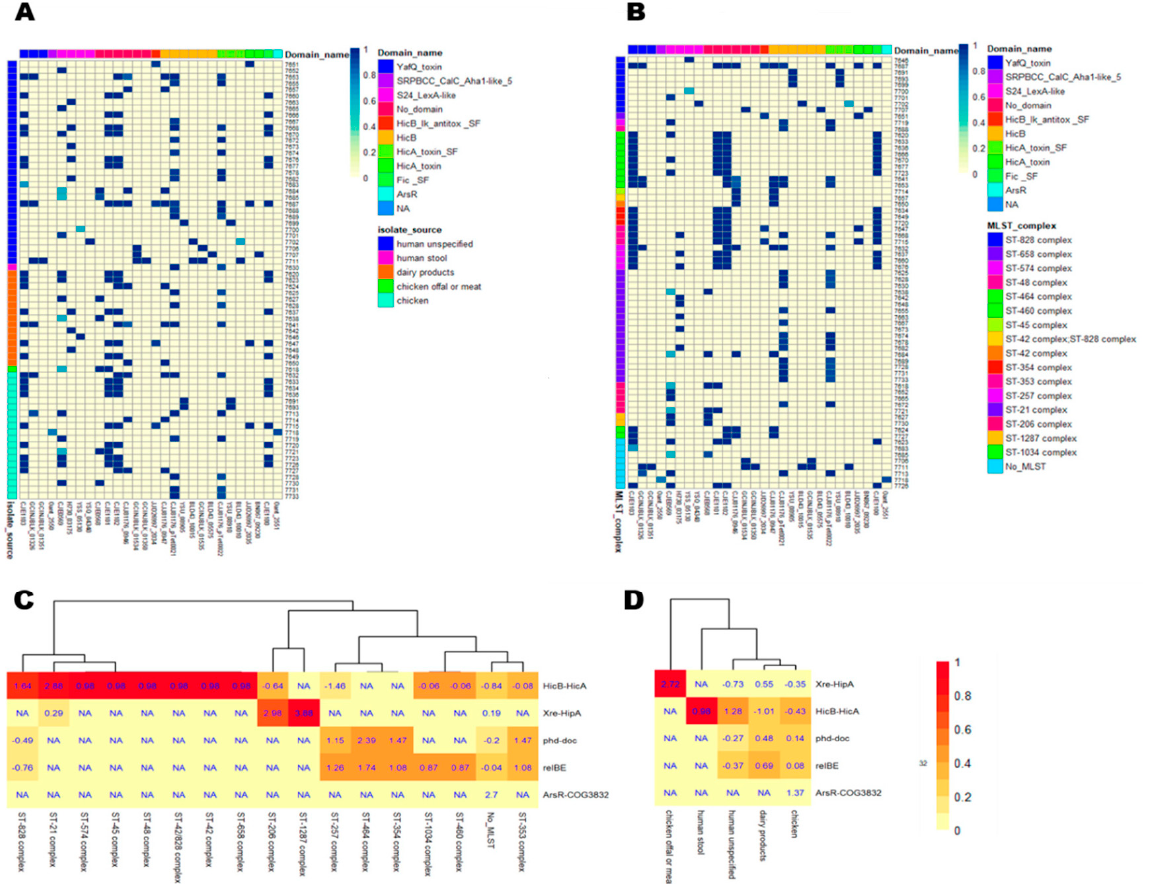
Figure 6. Heatmap showing the distribution of TA genes and families across isolates, isolate sources, and clonal complexes. In ( A , B ), each cell represents the occurrence of a TA gene (represented by the locus tag shown on the x-axis) for each isolate (shown on the y-axis). For the identification of a hit, a cut-off threshold of alignment length > 60% was applied, as proposed in [36]. The color conventions show the scaled score representing the alignment quality (see Methods). TA genes are grouped by their protein domain (shown as a colored track on top). In ( C , D ), each cell is colored by a normalized score, where the number of isolates in a given isolate source/clonal complex and a given family type is divided by the total number of isolates in a given isolate source/clonal complex, regardless of family type. In addition, cells are labeled by their standardized residuals as calculated from Pearson’s chi-square test. Residuals higher or lower than 2 or − 2, respectively, show a statistically significant association ( p < 0.05). ( A ) Isolates are grouped based on the isolate source (represented by a colored track on the left). ( B ) Isolates are grouped based on their clonal complex (represented by a colored track on the left). ( C ) Hierarchically clustered heat map between the TA family type and clonal complex. ( D ) Hierarchically clustered heat map between the TA family type and isolate